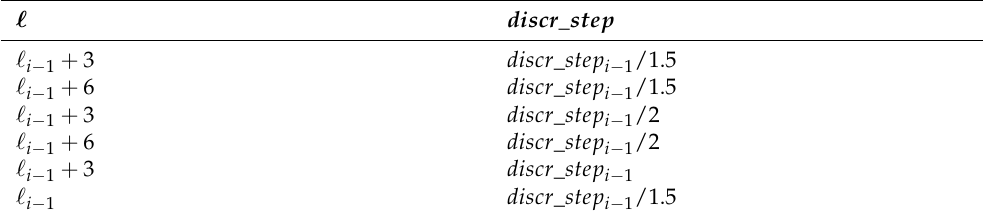
Table 6. Six variants of (cid:96) and discr _ step